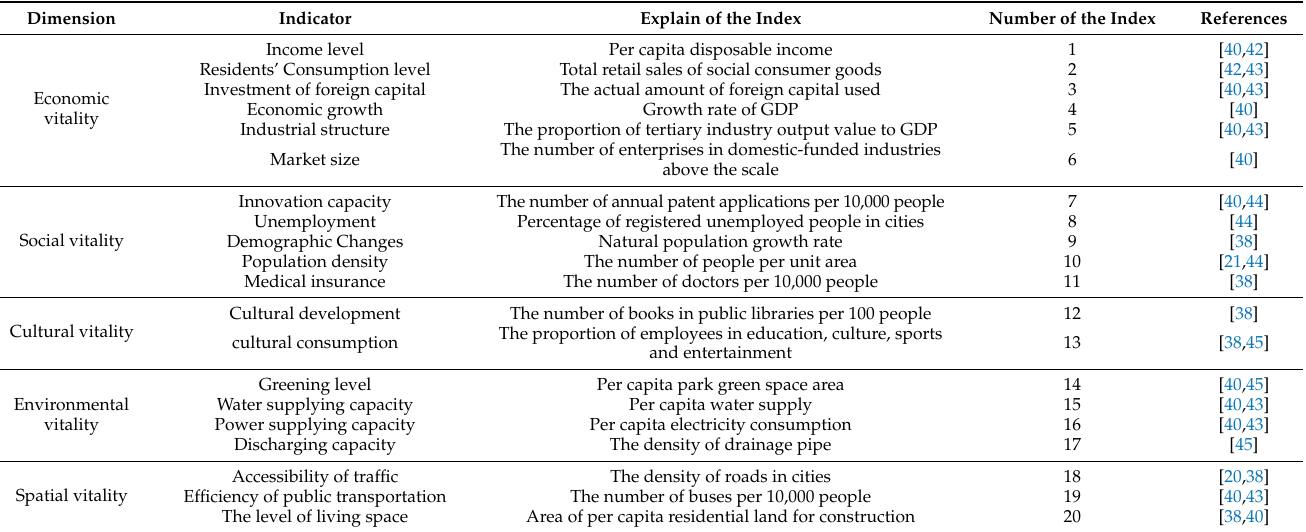
Table 3. Index system of urban